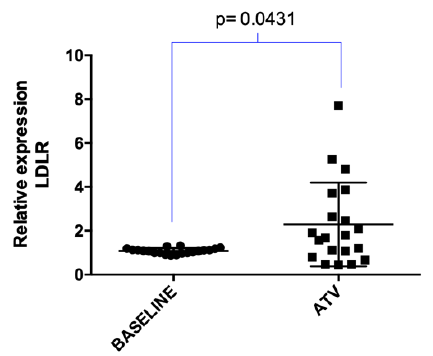
Figure 1. Expression of low-density lipoprotein receptor ( LDLR ) in hypercholesterolemic (HC) patients treated with atorvastatin. Relative quantification was completed by real-time PCR from total RNA extracted from leukocytes from HC patients before (baseline) and after treatment with atorvastatin (ATV, 20 mg / day / 4 weeks). p -value was obtained by paired t -Test. Normalization was done using ribosomal protein L27 (RPL27) as the reference gene.